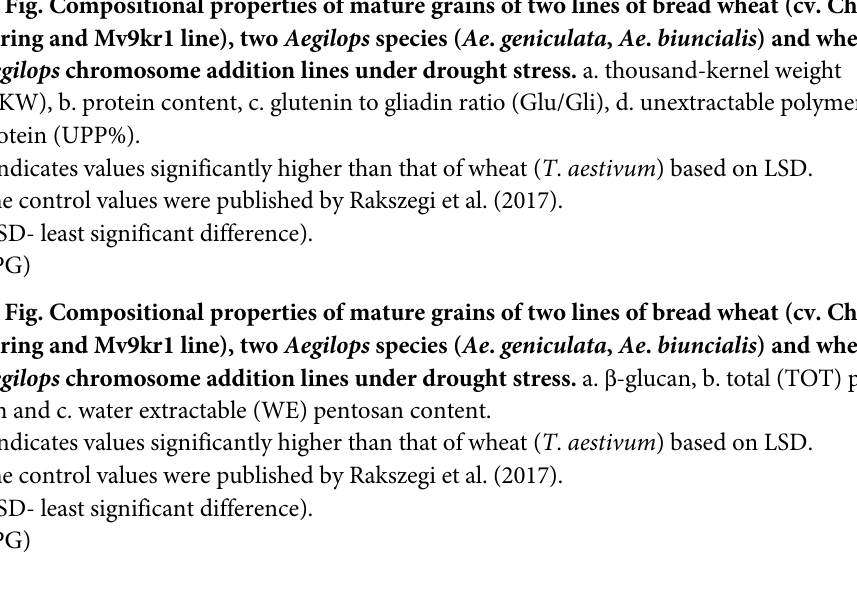
S1 Fig. Compositional properties of mature grains of two lines of bread wheat (cv. Chinese Spring and Mv9kr1 line), two Aegilops species ( Ae . geniculata , Ae . biuncialis ) and wheat- Aegilops chromosome addition lines under drought stress. a. thousand-kernel weight (TKW), b. protein content, c. glutenin to gliadin ratio (Glu/Gli), d. unextractable polymeric protein (UPP%).